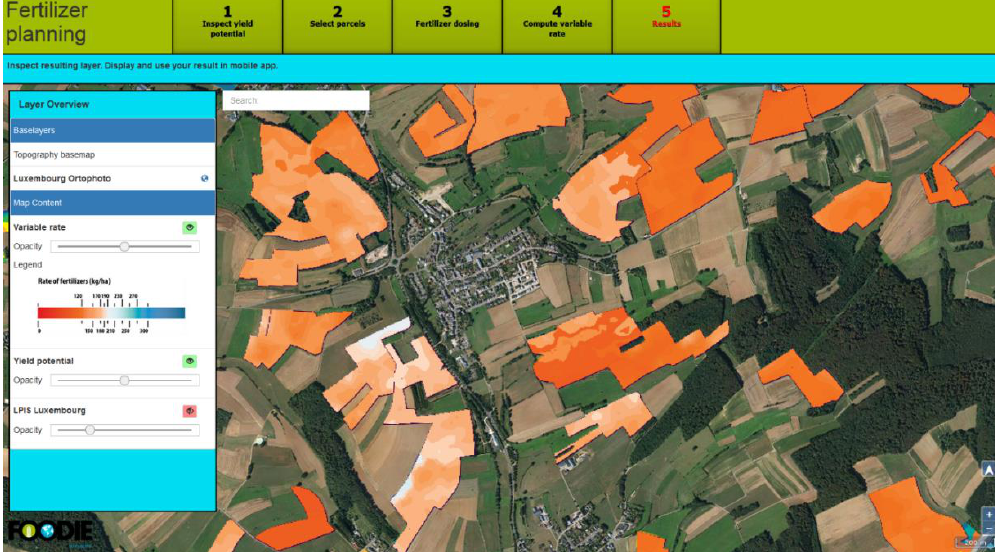
Figure 4. Fertilizer planning application based on yield potential zones as a tool for farmers to minimize the environmental burden as well as risk of water pollution.